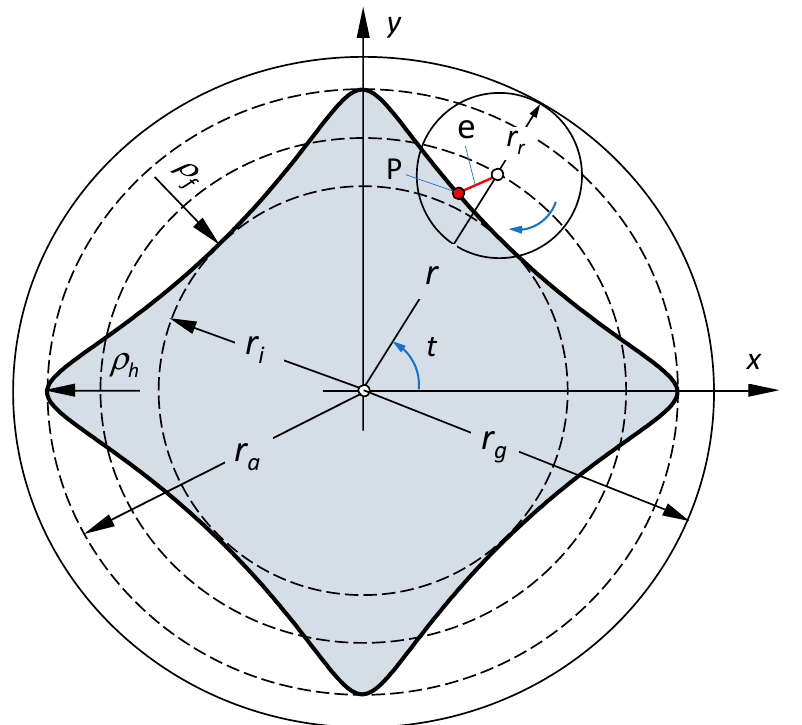
Figure 1. Description of exemplary hypotrochoid (H-profile) with four concave sides. A detailed explanation of the parameters is given below in Section 2.